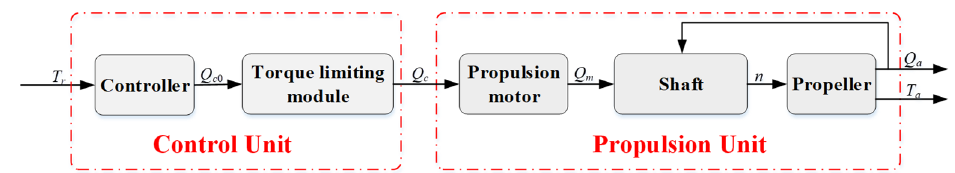
Figure 1. Structure of the MEP system.